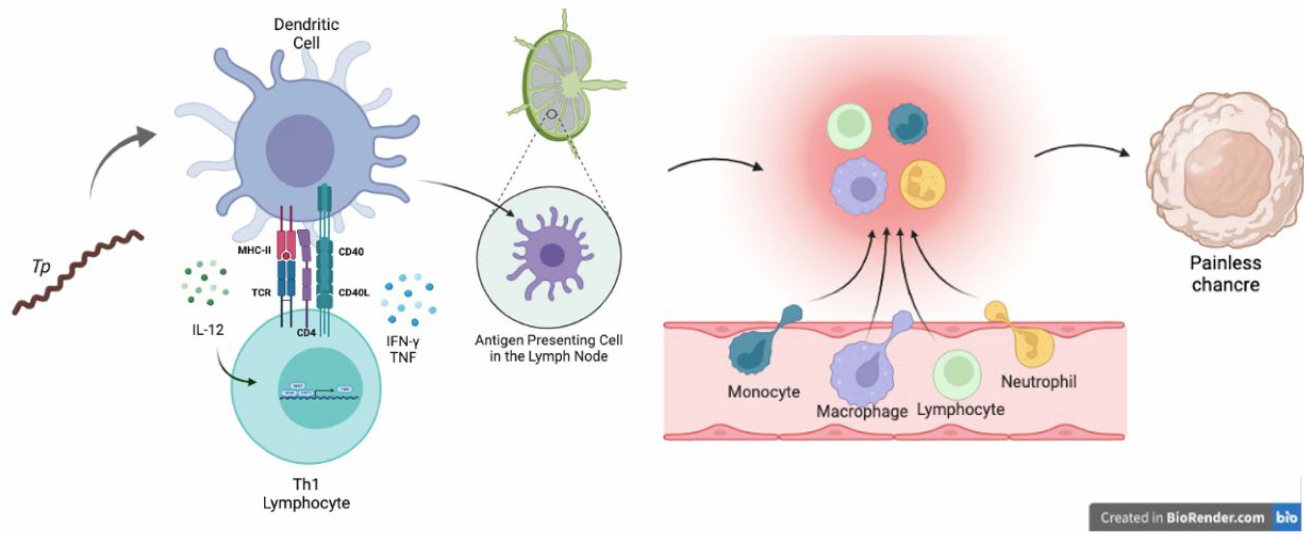
Figure 3. Immunological synergy between a dendritic cell and a T helper type 1 cell in response to Treponema pallidum and recruitment in the affected genital area. While Tpp is delivered into mucocutaneous wounds, DCs may recognize and phagocytose this pathogen, migrate toward lymph nodes and present antigen through MHC class II to Th lymphocytes. DCs begin to produce IL-12 to stimulate T cells to differentiate into the Th1 type and produce effector cytokines, such as TNF and IFN- γ . After antigen presentation, cells migrate from the lymph node to the affected area as a local response to clear the damage made by the